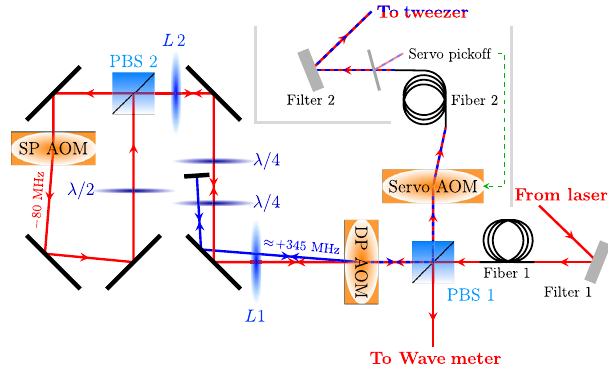
FIG. 2. Beam path for generating two frequencies in the tweezer for the Raman transition (only essential optics shown). Two filters, one directly after the laser source and one after both optical fibers, clean the light from a fiber amplifier seeded by an external cavity diode laser. The red beam path is the always- present zeroth order of the double pass (DP) AOM. The blue beam path is the switchable first order of the DP AOM. It generates the second frequency for the Raman transition. To reduce interferences that cause relative power fluctuation of the two frequencies, the zeroth order is frequency shifted by − 80 MHz before recombination. The experiment typically starts with the single-pass (SP) AOM on and the DP AOM off. When driving the Raman transition, the rf powers for both AOMs are ramped simultaneously to achieve the desired optical power at both frequencies, while keeping the total optical power fixed.